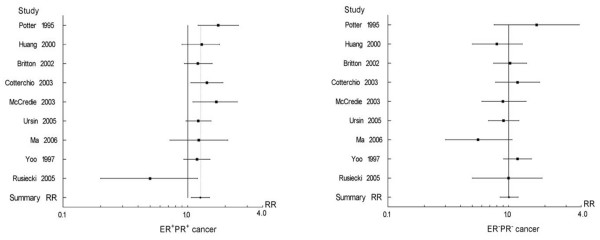
Age at first birth and breast cancer risk by estrogen receptor/progesterone receptor (ER/PR) status: relative risk (RR) with corresponding 95% confidence interval for oldest versus youngest age at first birth category.